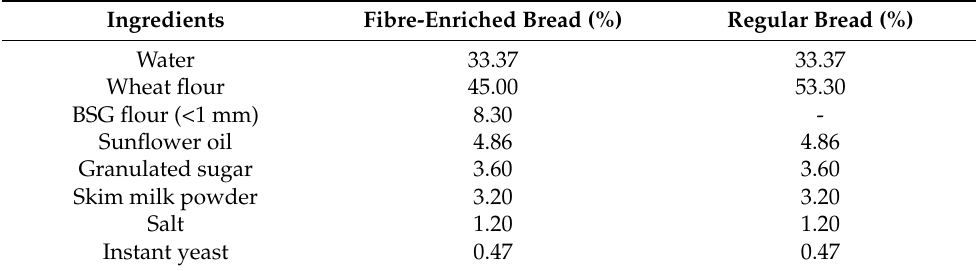
Table 1. Formulations of fibre-enriched bread and regular